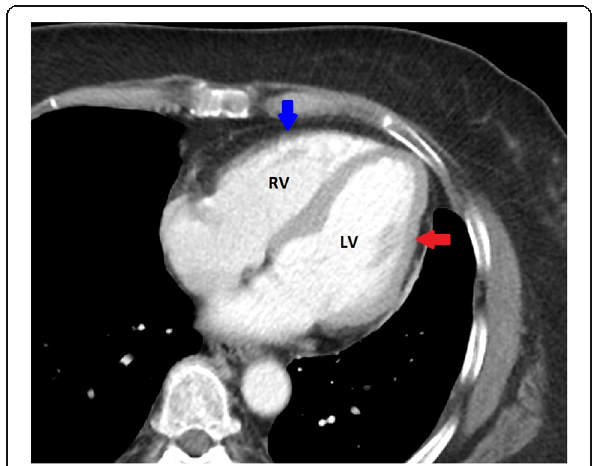
Fig. 1 Right and left heart. Blue arrow demonstrates the right ventricle with a thin wall and crescent shape. Red arrow demonstrates the thicker wall of the left ventricle